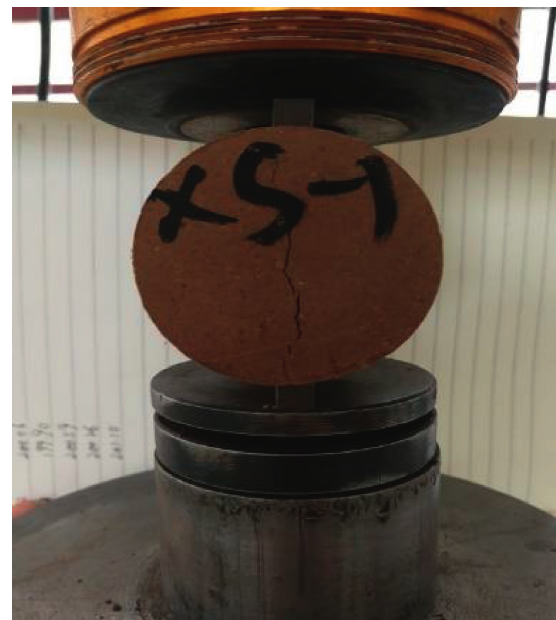
Figure 4: STS test